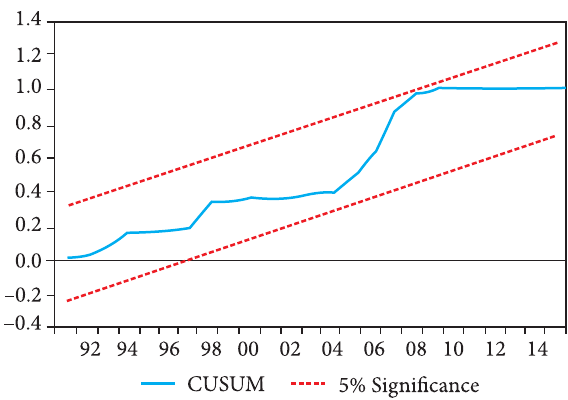
Figure 2. Plot of CUSUM of squares of recursive residuals (Asymmetric